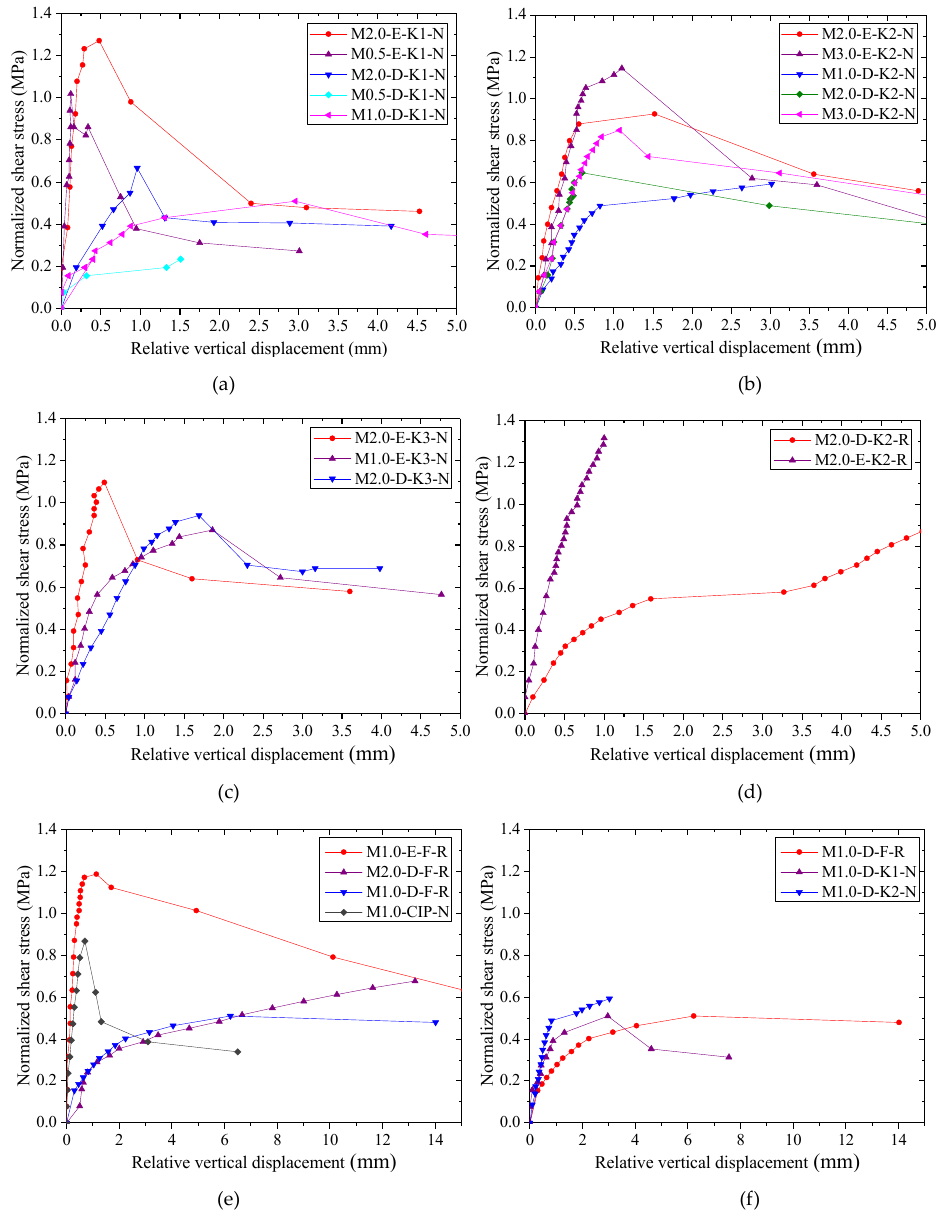
Figure 8. Normalized average shear stress-relative vertical displacement relationships of specimens with dry and epoxied joints: ( a ) specimens with single shear key; ( b ) specimens with two shear keys; ( c ) specimens with three shear keys; ( d ) specimens with two shear keys and with dowel reinforcement; ( e ) flat joints and integral cast-in-place specimens; ( f ) dry flat reinforced, dry single-keyed and two-keyed